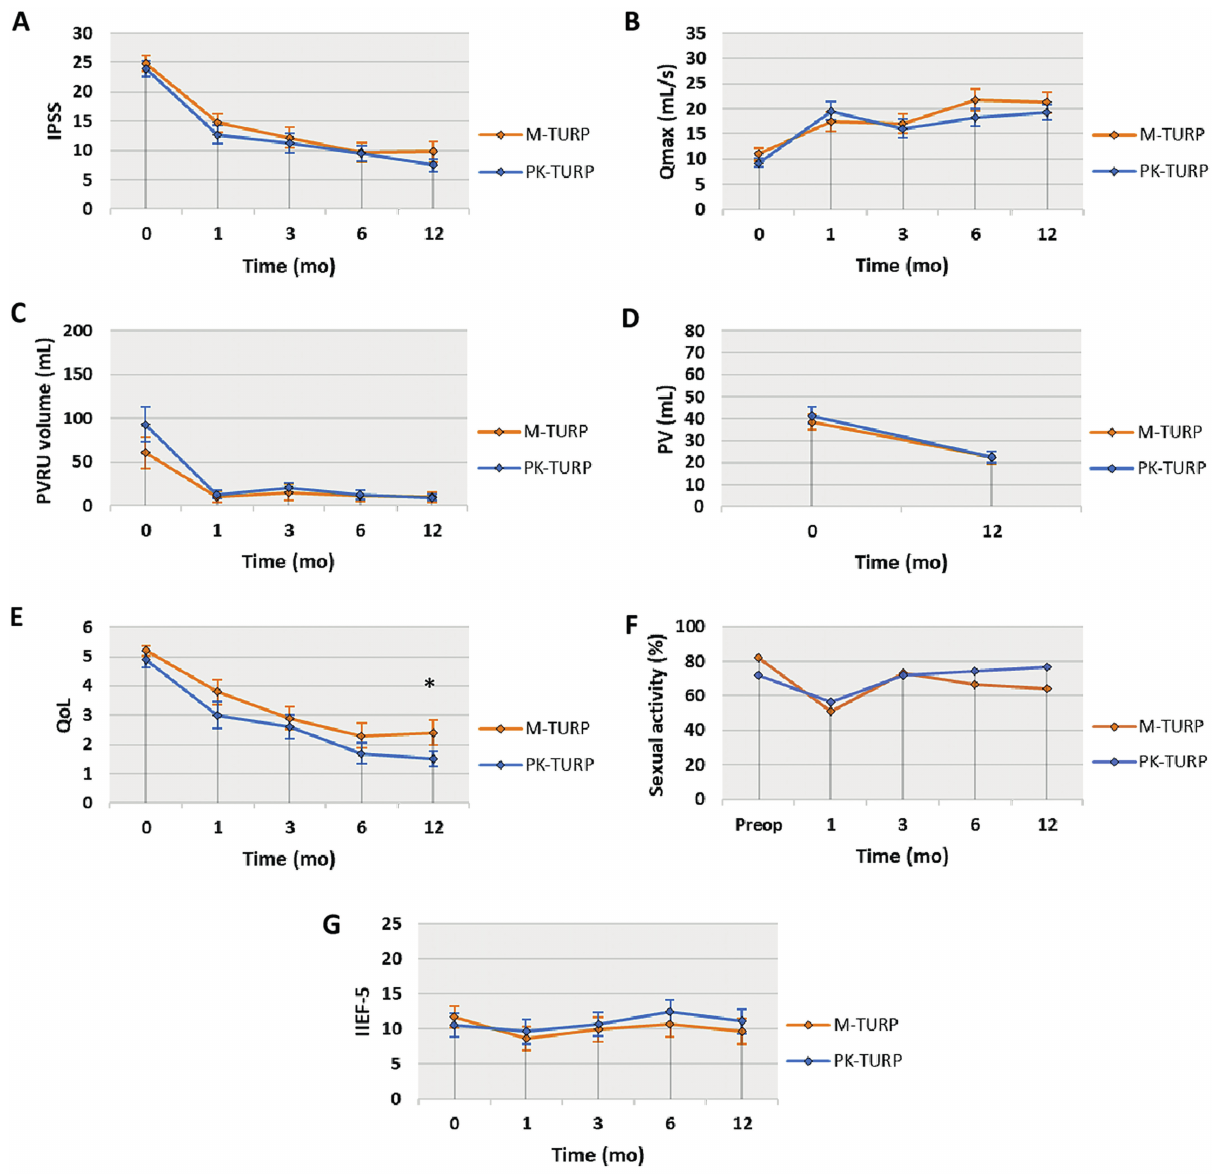
Figure 2 - Outcome following treatment with M-TURP or